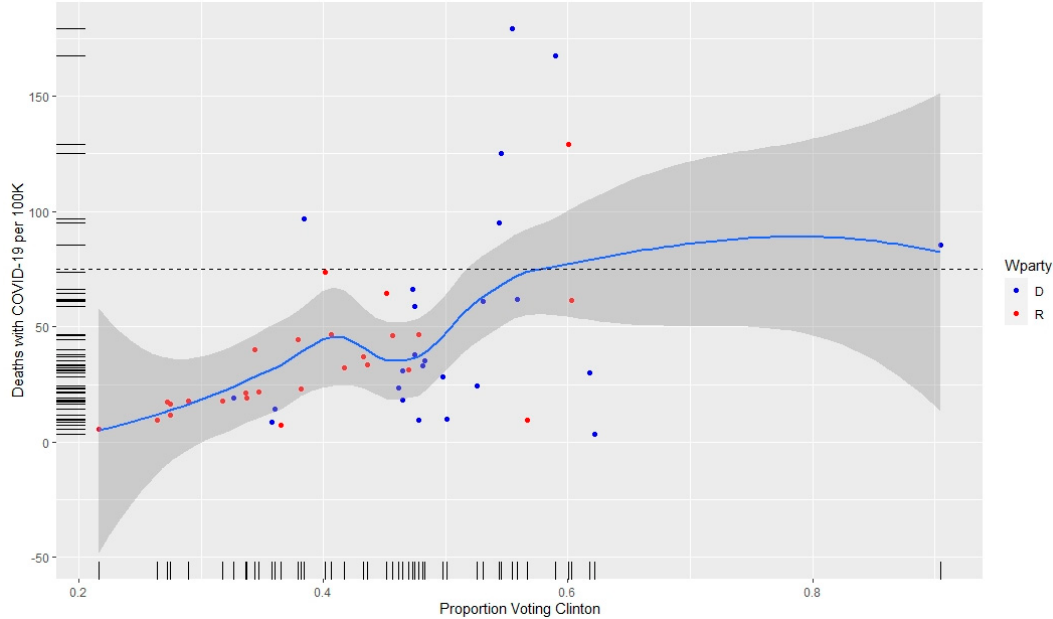
Figure 2. Coronavirus (COVID-19) death rates per 100,000 ( y axis) as a function of proportion voting for Clinton in 2016 ( x axis) and the current party of the governor as a red or blue dot.